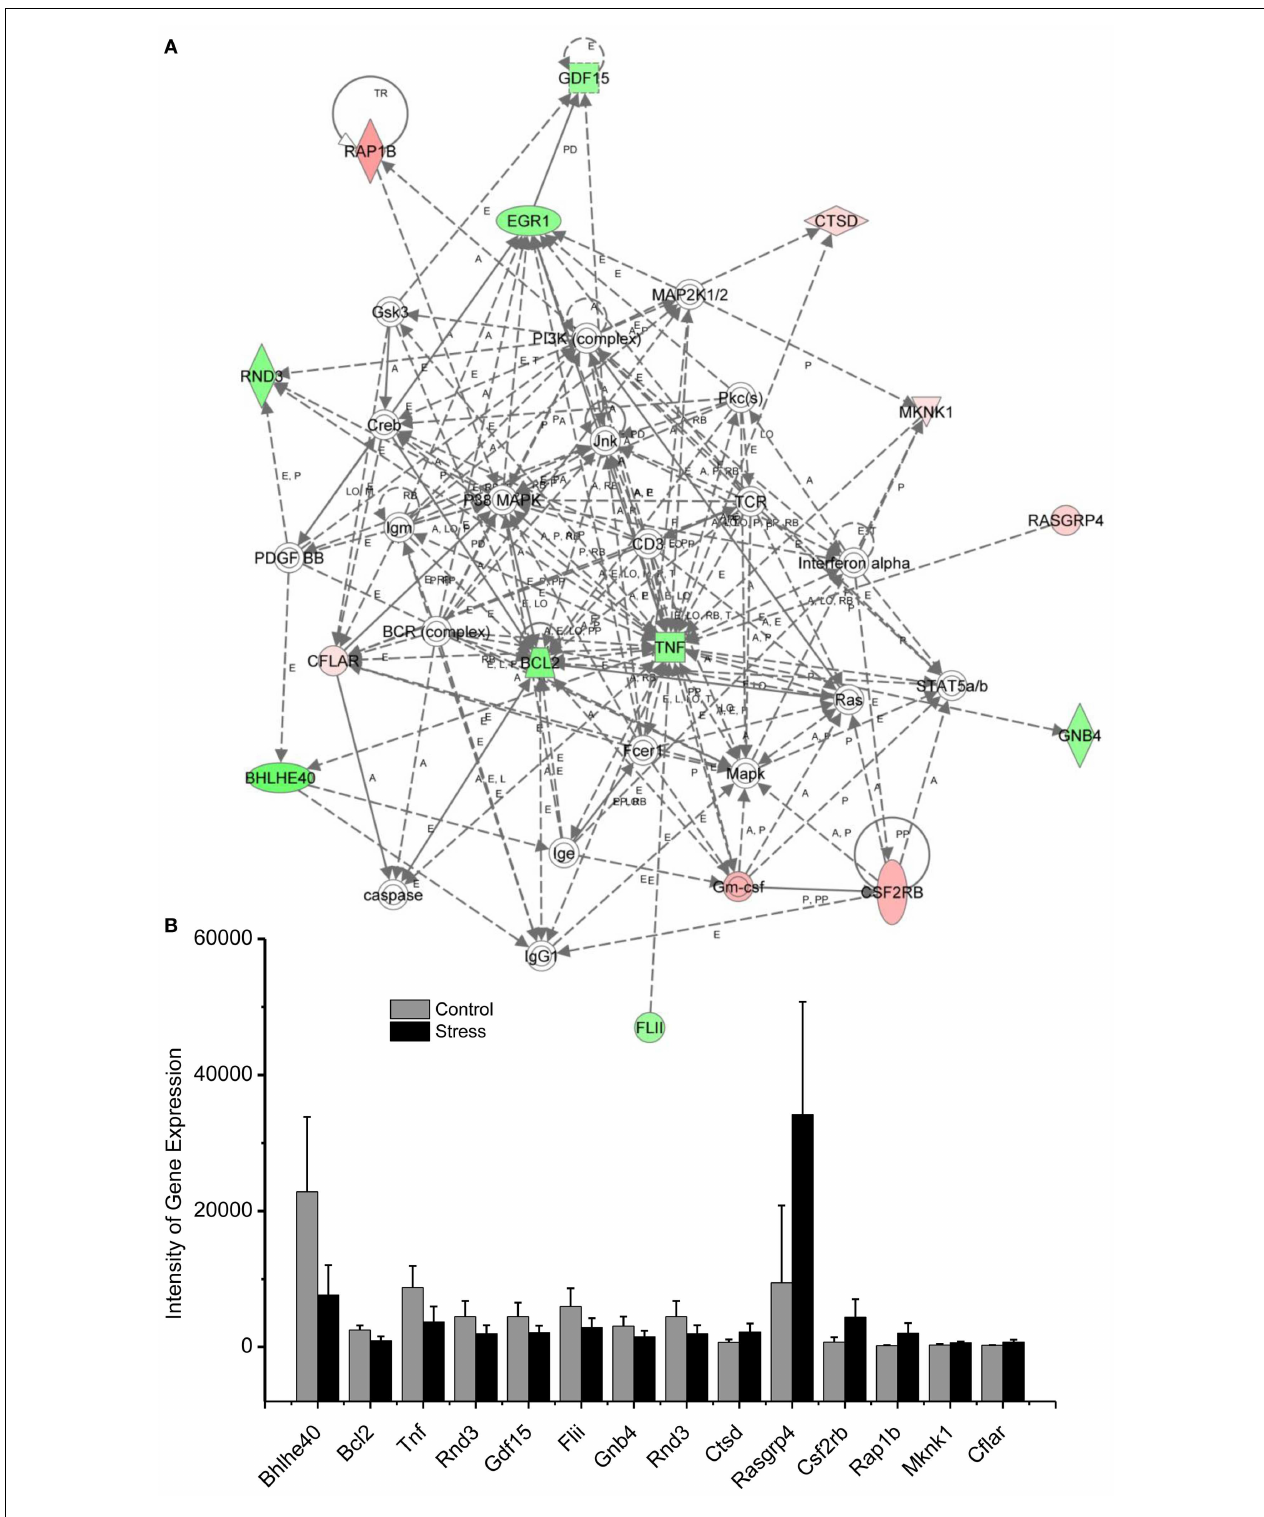
( p < 0.01, n = 10) for the network associated with Bcl-2 andTNF in the amygdala 14days after stress.The order is plotted according to fold change, from downregulated with lowest negative value to upregulated with highest positive